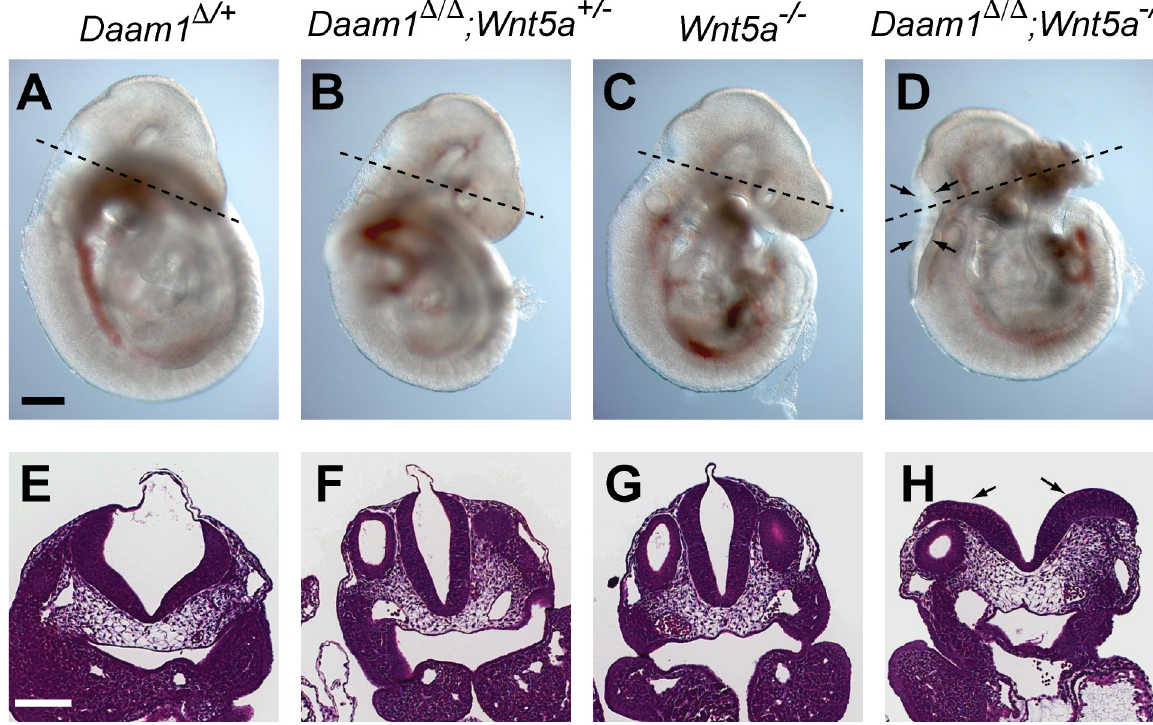
Fig 4. Neural tube closure defects in Daam1 ; Wnt5a double mutants. (A-D) Lateral view of (A) Daam1 Δ /+ , (B) Daam1 Δ / Δ , Wnt5a +/- , (C) Wnt5a -/- and (D) Daam1 Δ / Δ , Wnt5a -/- embryos at E9.5. H&E staining of cross-sections of the embryos shown in A-D through the fourth ventricle (E-H) Section positions are indicated by dotted lines in A-D. Arrows indicate the open neural tube. Scale bars = 200 μ